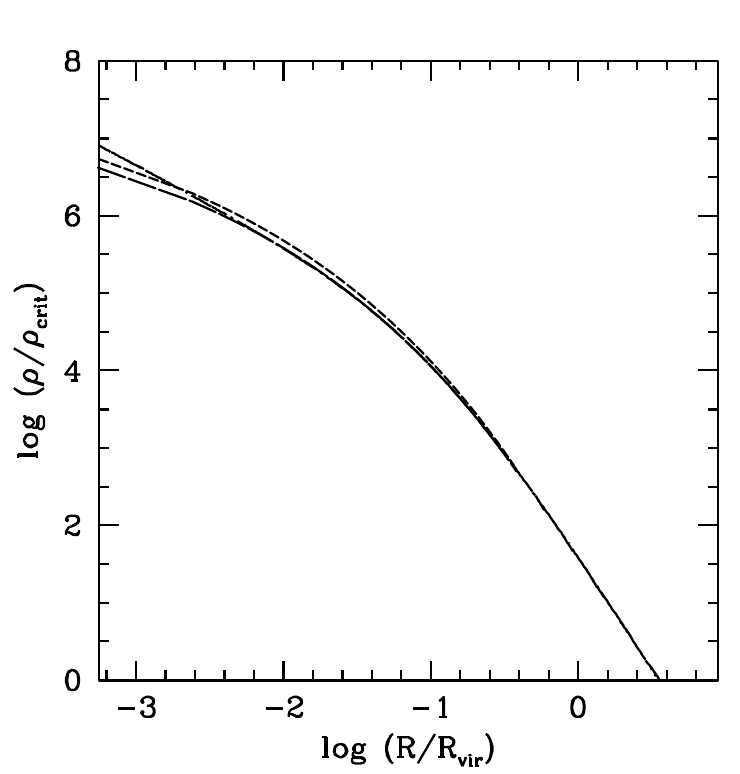
Fig. 3. Comparison of halos generated by the model of the present paper (long-dashed line) with the numerical simulations. The solid line is the NFW pro(cid:12)le while the short- dashed line is the result of the Aquarius experiment, both for a halo with 10 12 M ⊙